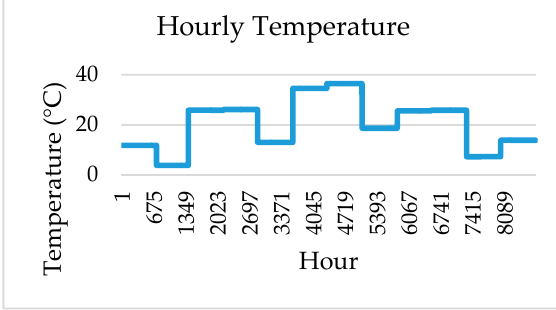
Figure A4. Hourly Temperature.